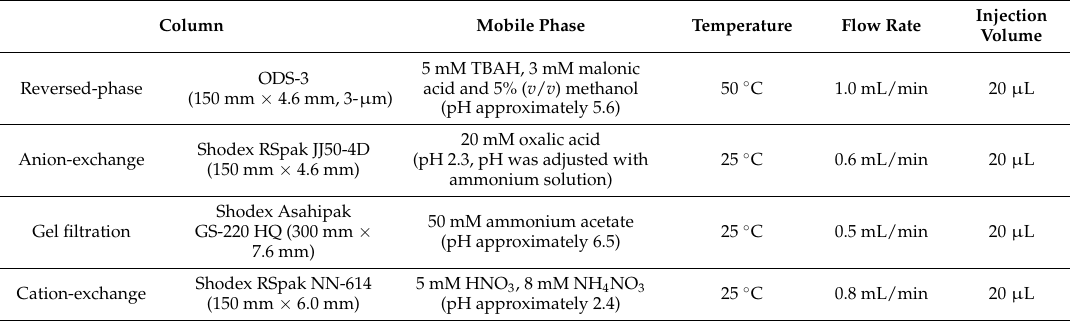
Table 1. Analytical conditions of HPLC.